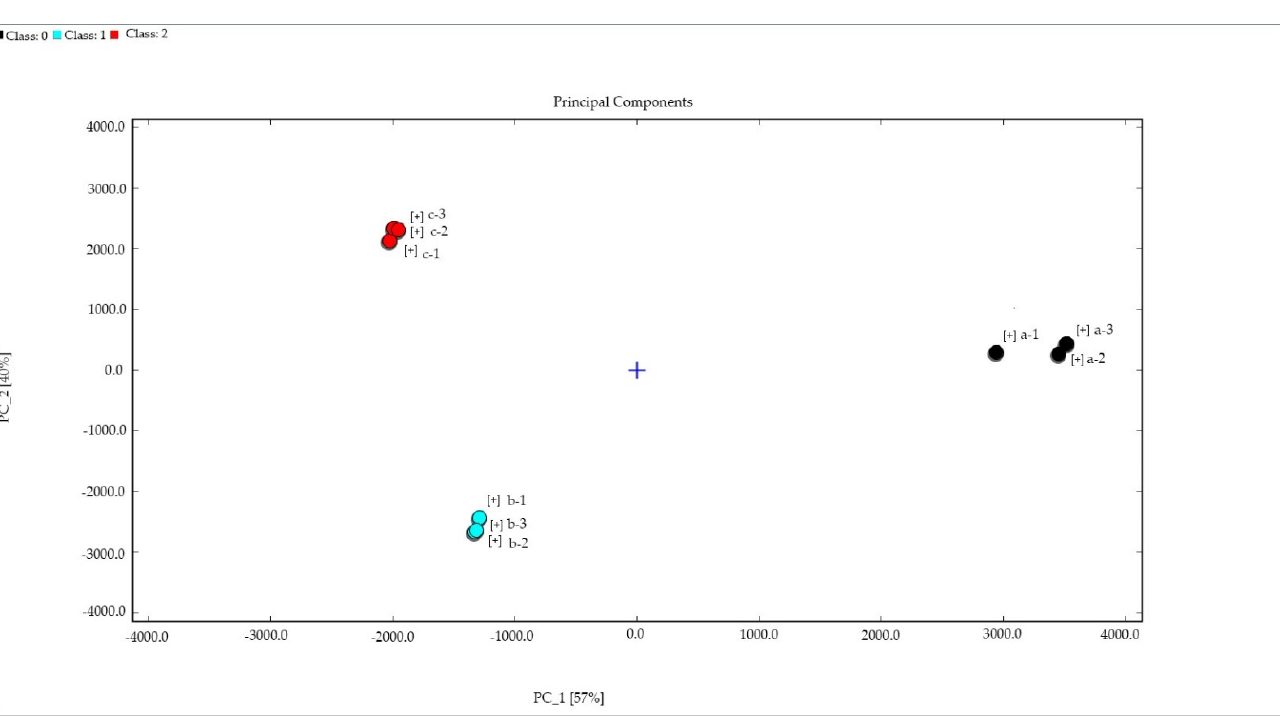
Figure 5. PCA of different samples. a: Oil cistanche, b: blood cistanche, c: cistanche tubulosa in Xinjiang.